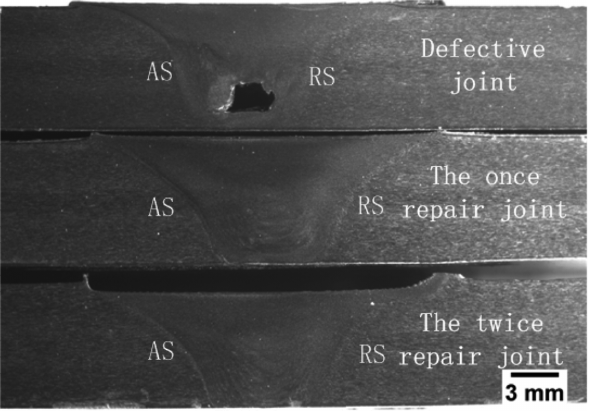
Figure 1: Macrostructure of the original and repaired